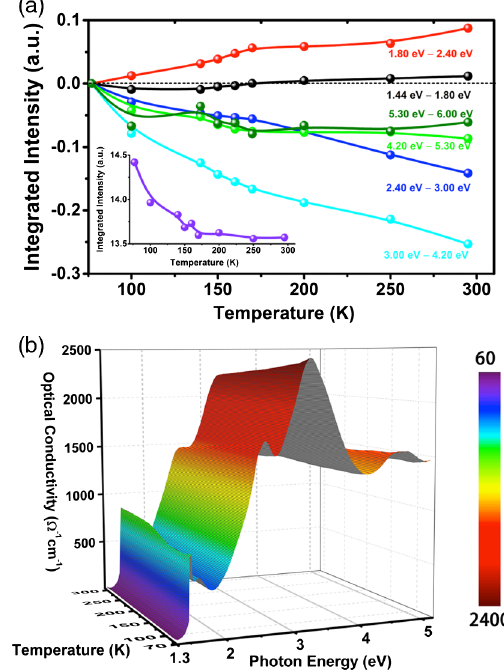
FIG. 3. (a) The change in integrated intensity of the imaginary part of the dielectric function as a function of temperature for different spectral ranges. Inset: The change in the integrated intensity across the whole energy spectrum as a function of temperature. (b) Surface plot of the optical conductivity of FA 0 Cs 0 PbI 2 Br 0 as a function of temperature and photon . 85 . 15 . 9 . 1